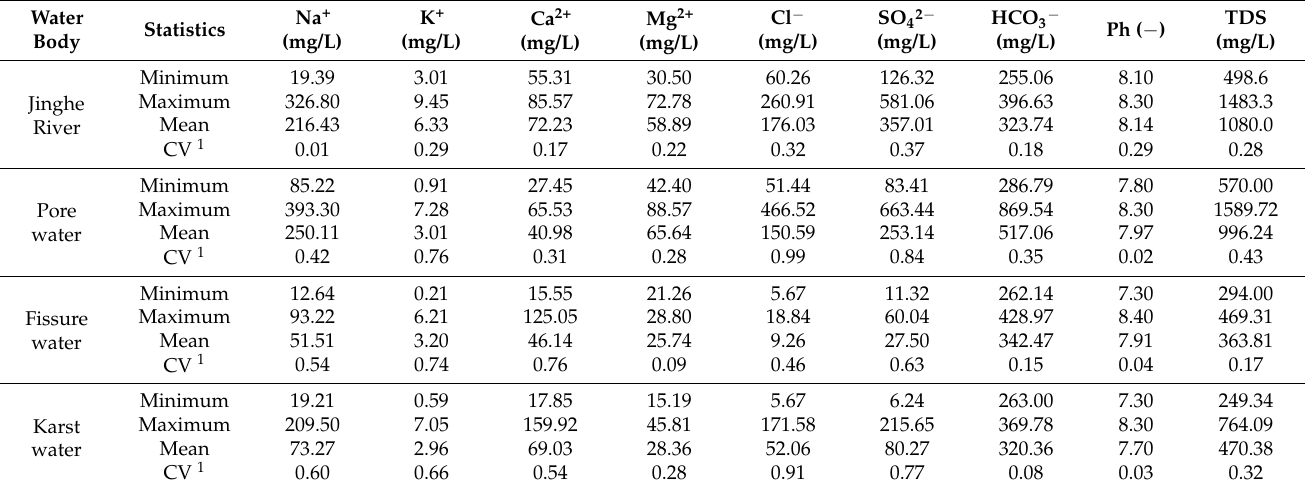
Table 2. Classical statistical characteristics of chemical components of different water